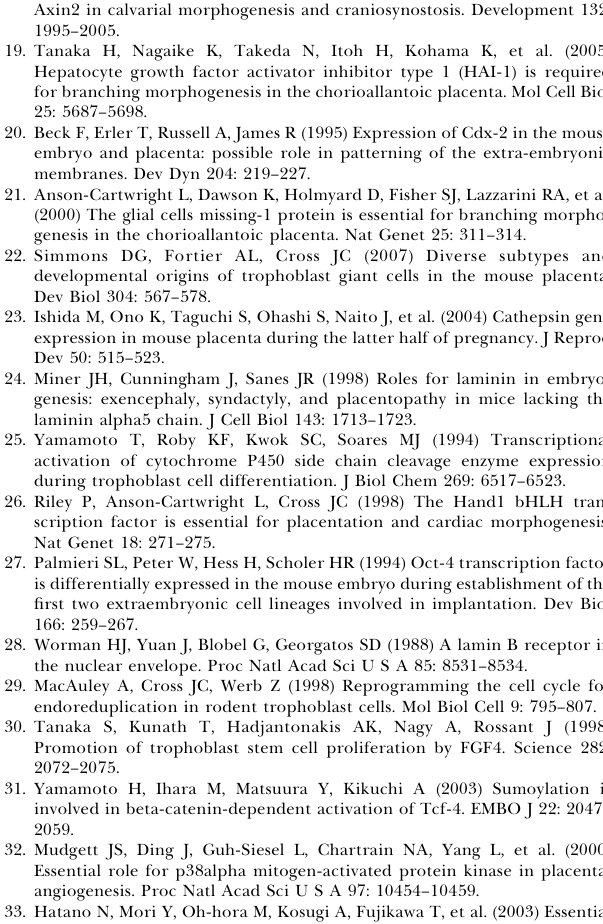
Figure S2. Programmed Cell Death Is Not Affected by the SENP2 Deletion